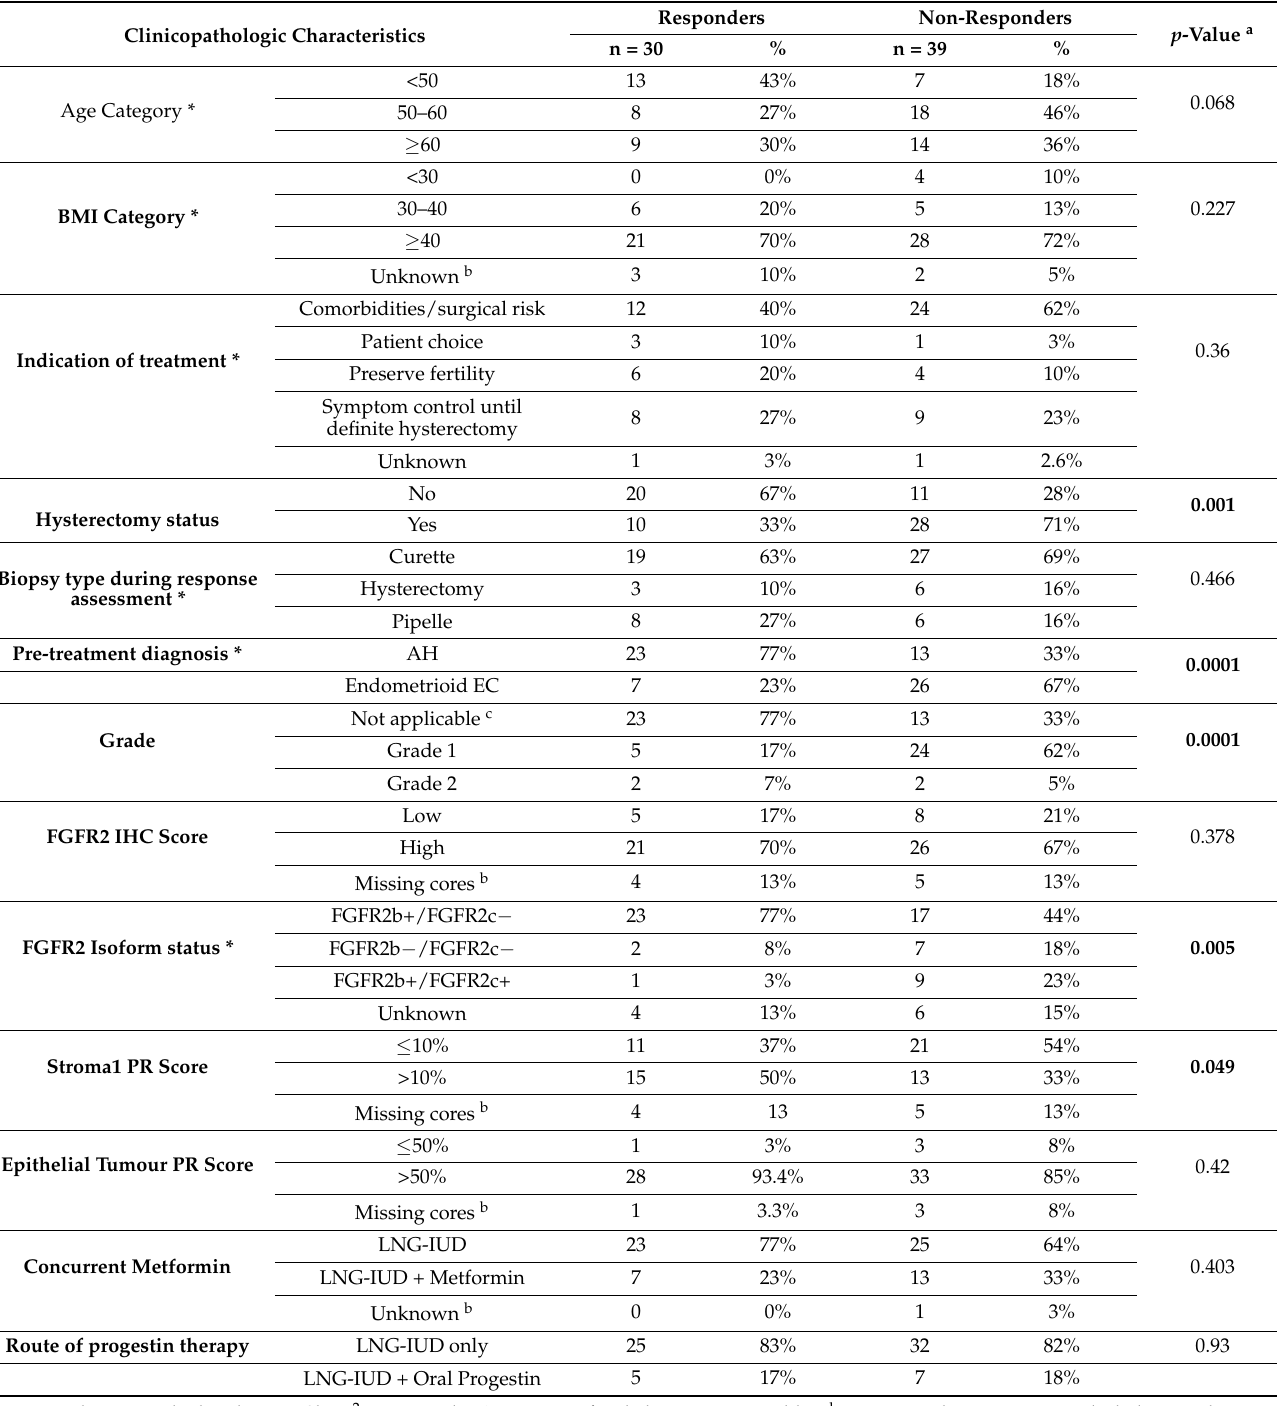
Table 1. Association of clinicopathologic markers and FGFR2 isoform with treatment outcome in the whole cohort. Clinicopathologic